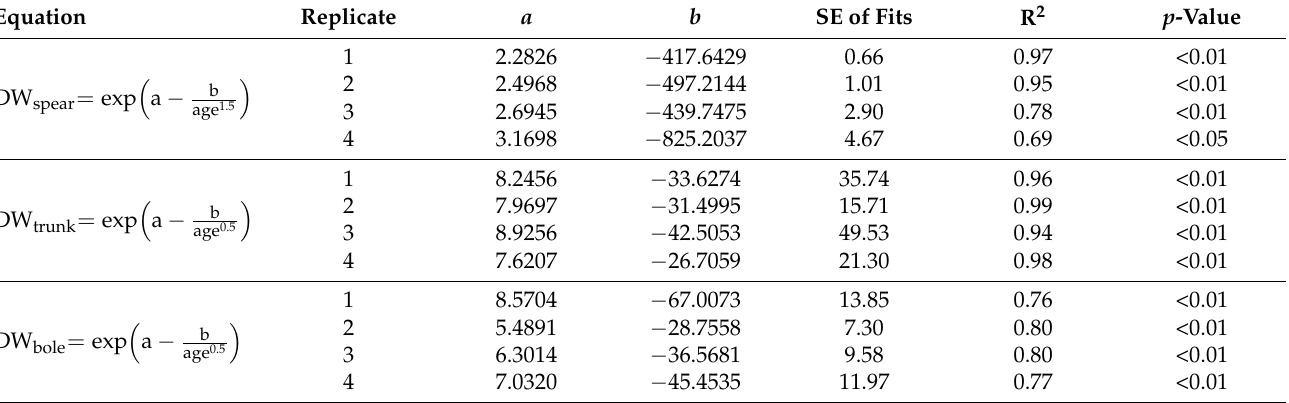
Table 3. Equations to calculate the cumulative dry matter incorporated in spear leaves, trunk, and bole of tenera oil palm. The variable ‘age’ is the number of months since nursery planting and DW spear , DW trunk , and DW bole are dry weights (kg palm − 1 ) accumulated in spear leaves, trunk, and bole, respectively, at the time of